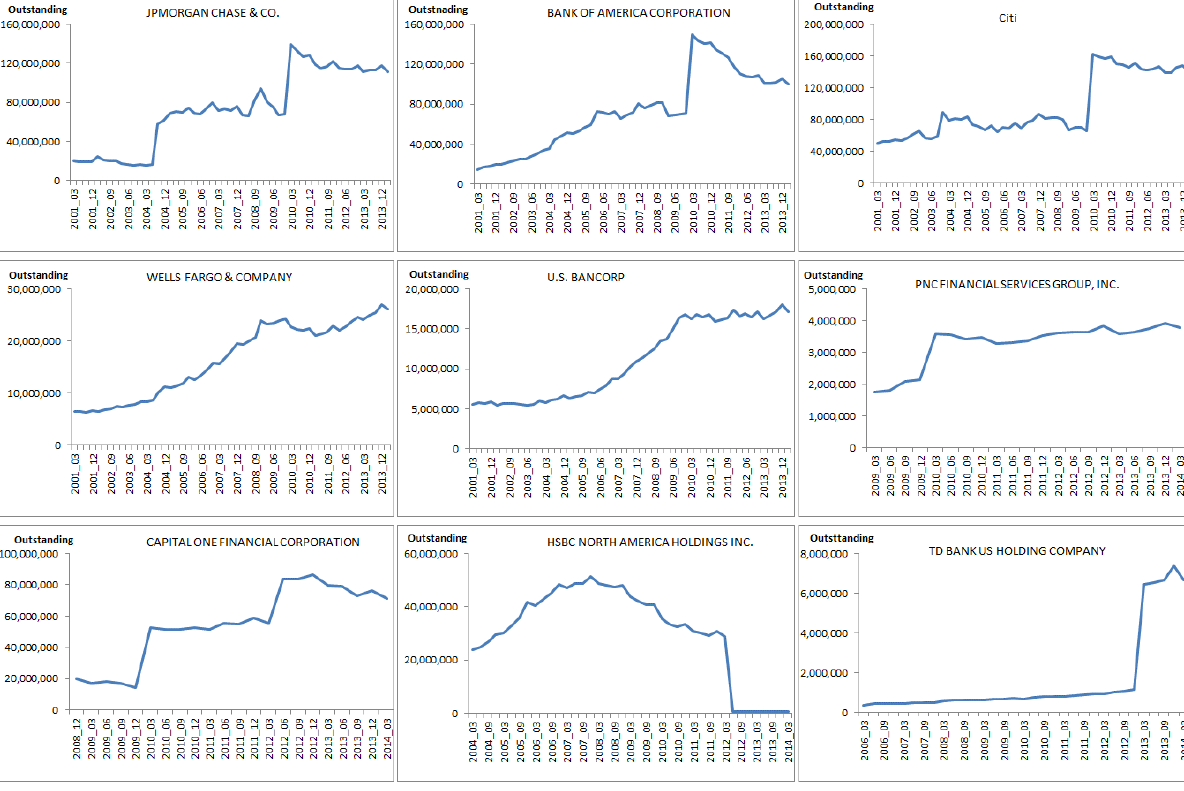
Figure 2. Credit card outstanding reported by banks in FR Y-9C [kUSD]. Source: Author’s work.